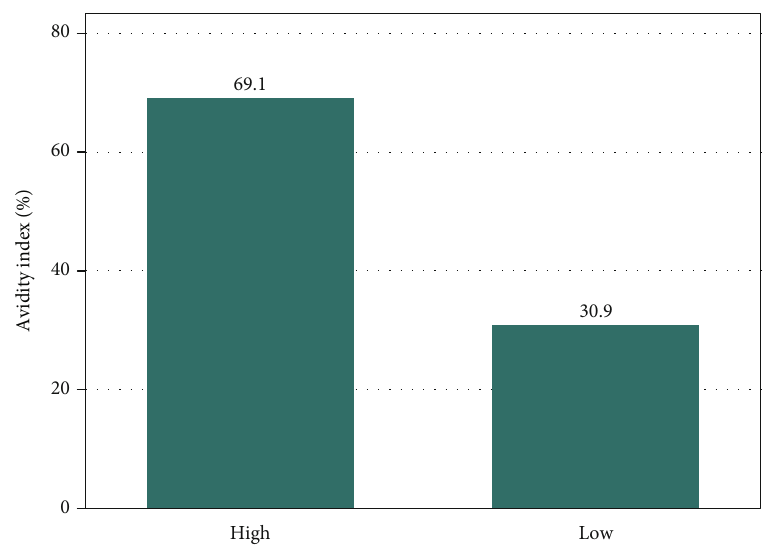
Figure 1: Avidity index values of IgG seropositive individuals with high